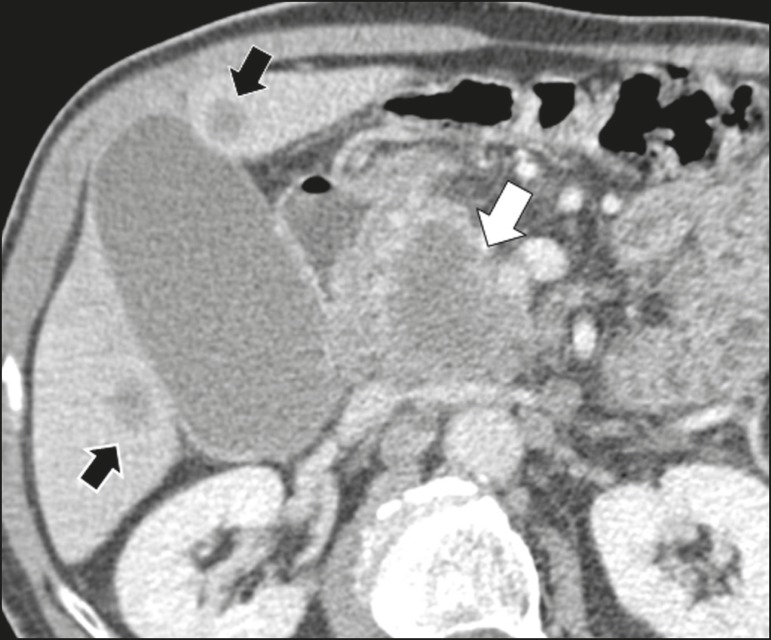
Contrast-enhanced CT scan showing a massive solid-cystic lesion in the
head of the pancreas, measuring 40 mm (white arrow), together with liver
lesions with aspects characteristic of secondary implants (black
arrows). Appearance of pancreatic adenocarcinoma.